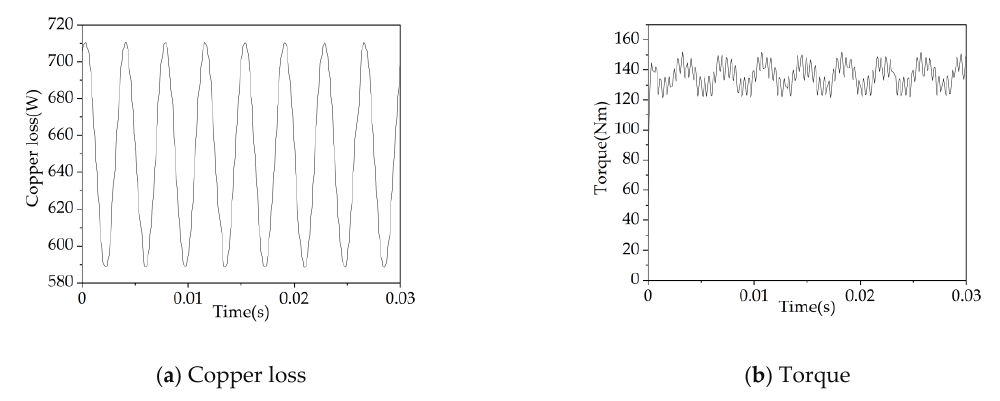
Figure 12. Copper loss and torque of the rated working condition of IWM.